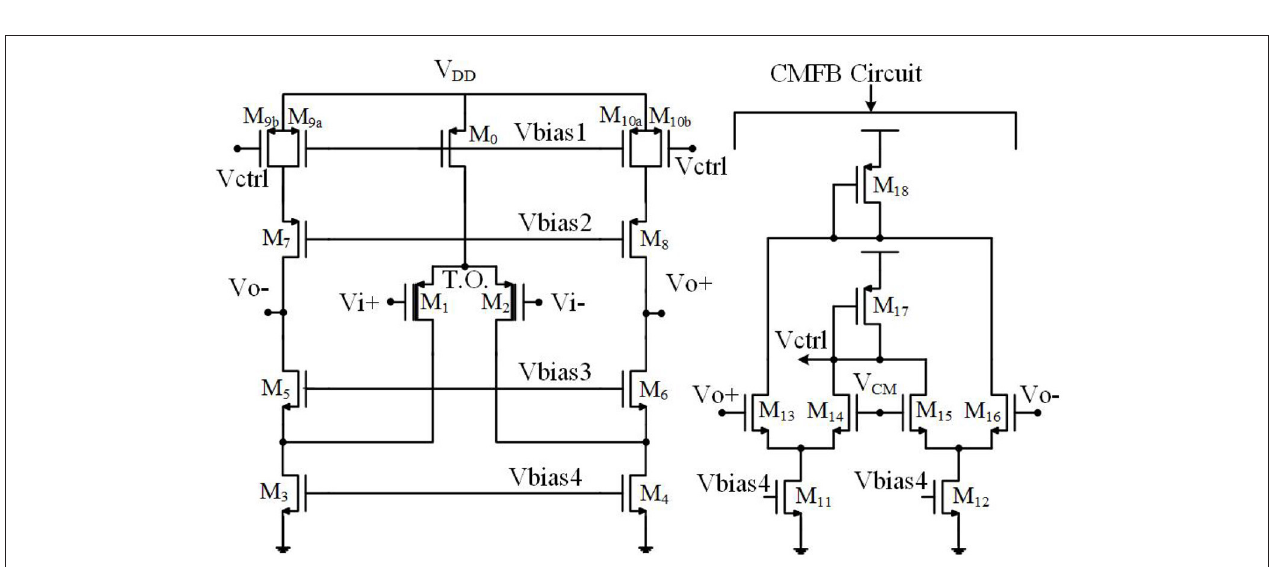
FIGURE 11 | Simulation of open loop frequency response (gain and phase) of the amplifier of Figure 8 with 70 degree phase margin.